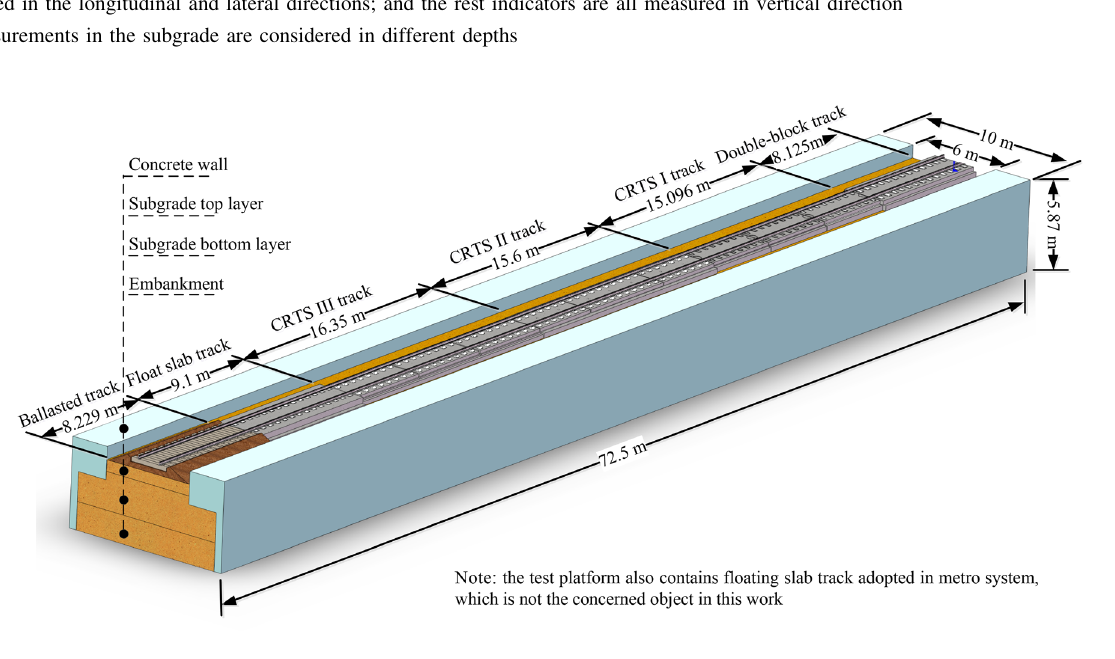
Fig. 3 Detailed design scheme of the test